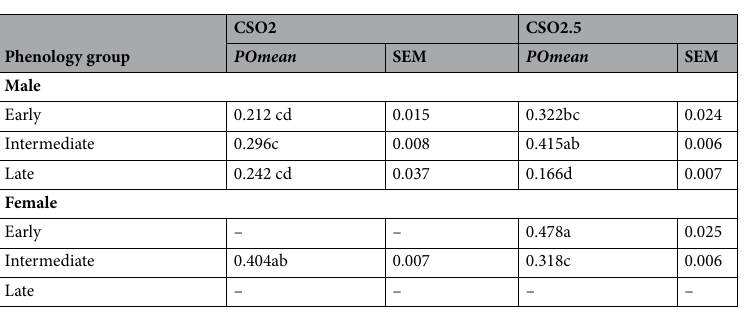
Table 3. Mean phenological synchronization index ( POmean ) values for female and male strobilus in three phenology classes over two seed orchards. “–” means no data, means within generations with different lowercase letters are significantly different at the 0.05 level. SEM the standard error of the